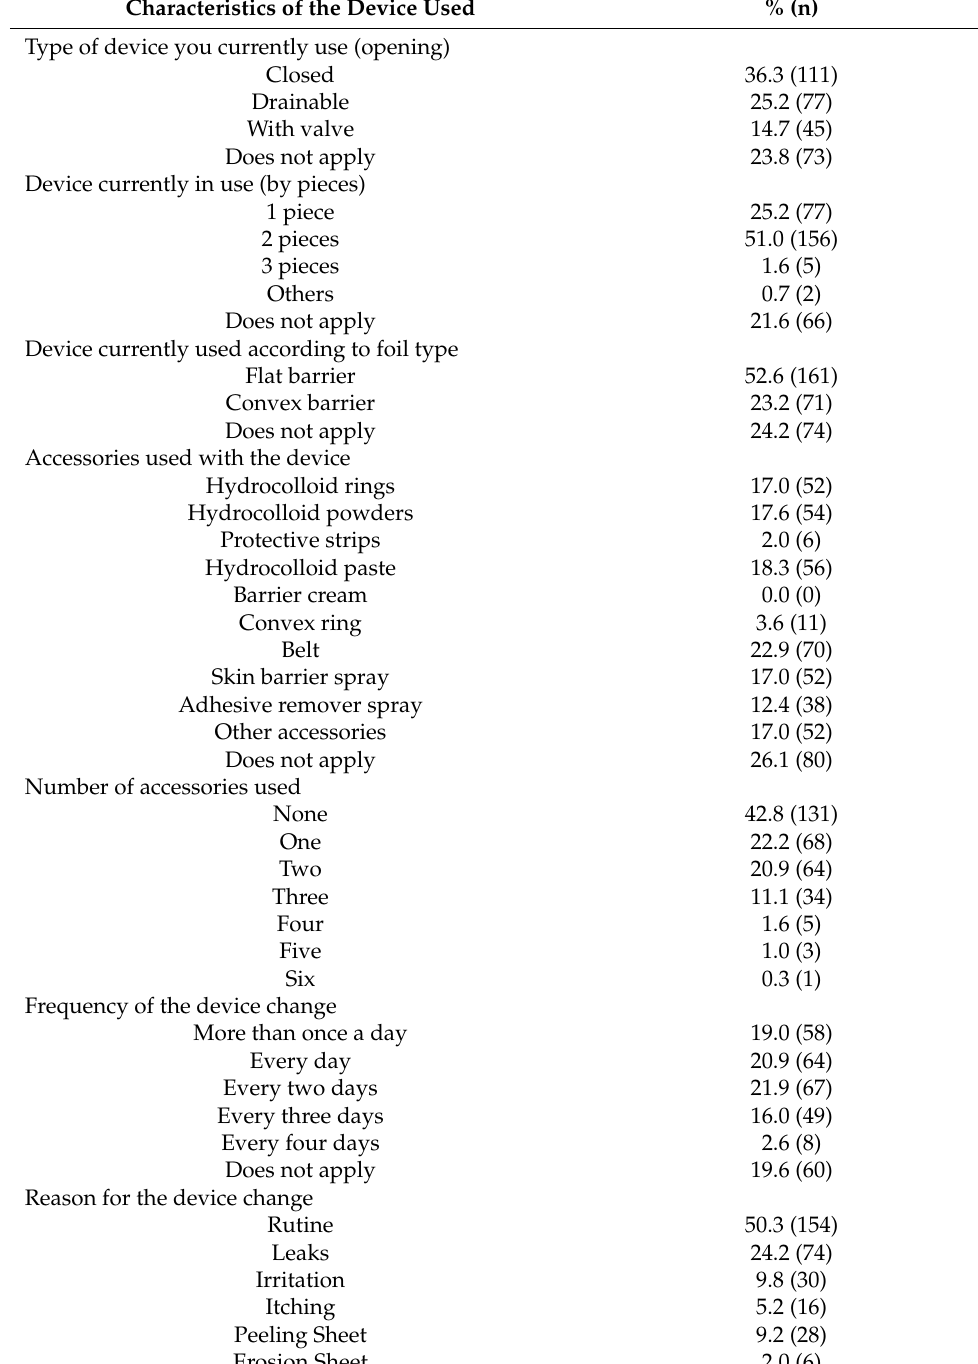
Table 2. Characteristics of the device used in the initial